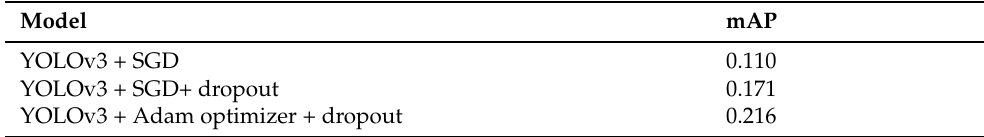
Table 14. Results of YOLOv3 on the DDR Dataset.